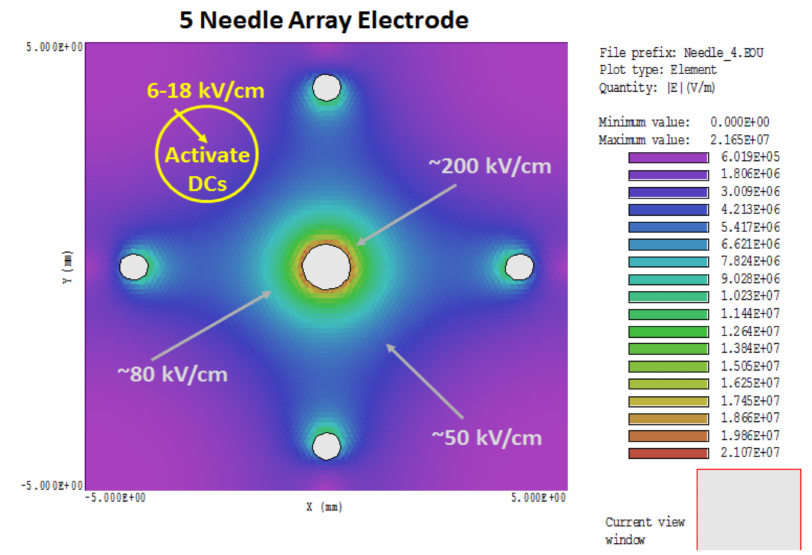
Figure 2. NPS electric field simulation: Electric fields were simulated from an NPS treatment zone of 50 kV/cm (25 kV across 0.5 cm) using a 5-needle electrode array. The electric field is heterogeneous with very high electric fields near the needles and lower, nonlethal electric fields in the periphery where DCs can be activated by